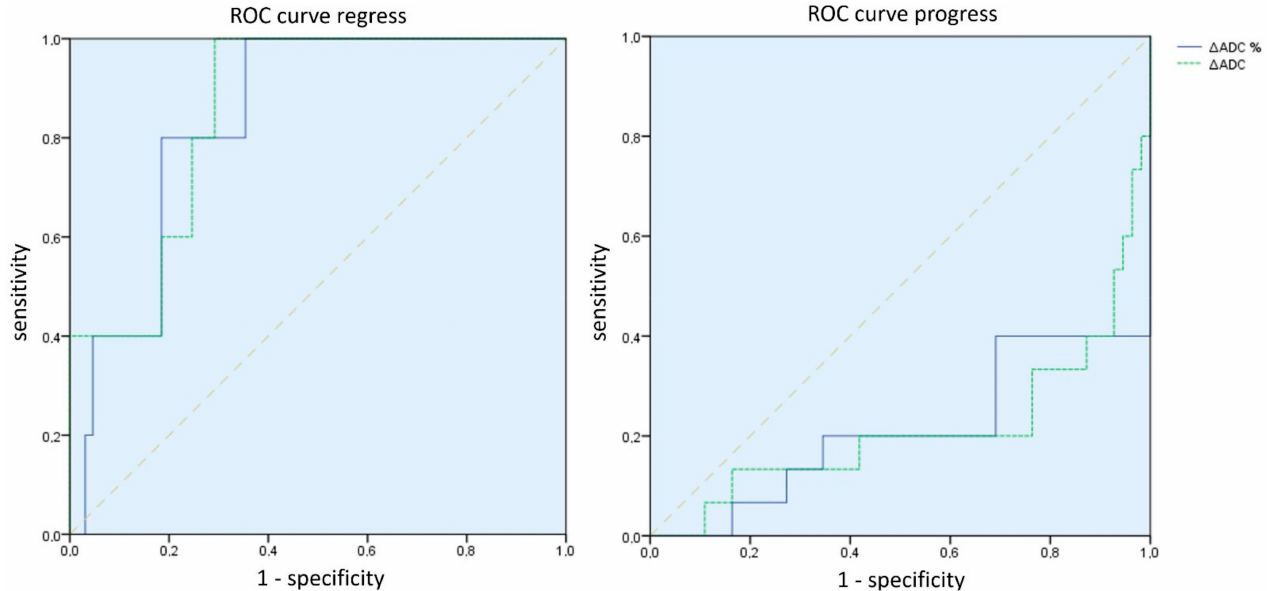
Figure 5. ROC curves of the absolute (green) and percentage (blue) ∆ ADC values for regress and progress prediction. It is shown that both an ADC decrease as a parameter in tumor progression and, in particular, an ADC increase as a parameter in tumor regression have a high ability to discriminate.